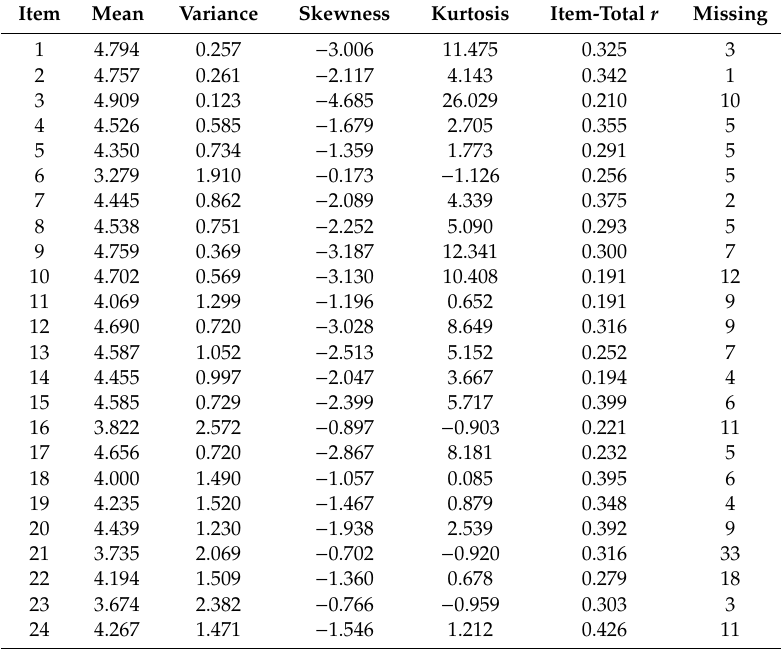
Univariate descriptive statistics for the Children’s Satisfaction with Hospitalization Questionnaire (CSHQ)